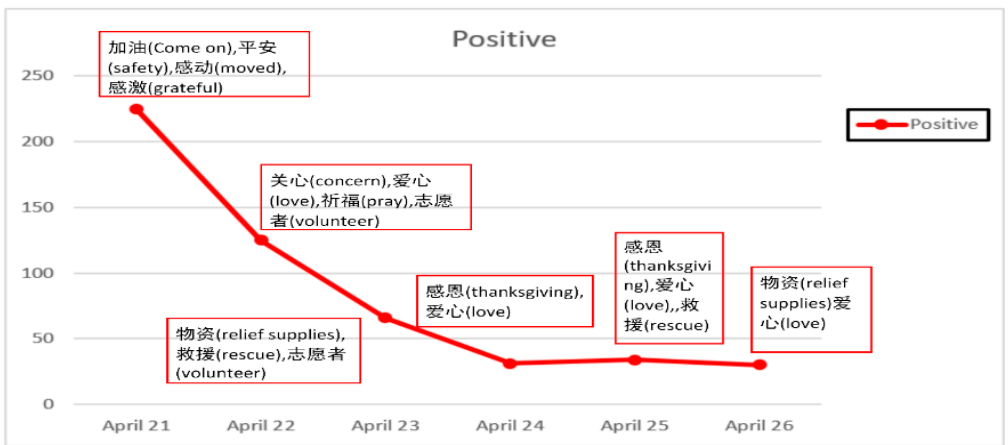
Figure 9. Sequence diagram of positive emotion (the words in the text box are the hot words related to this emotion in the corresponding time period).